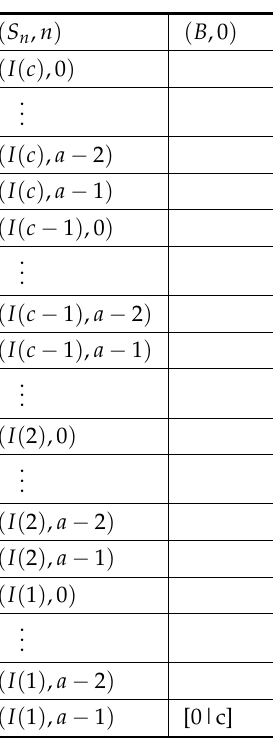
Table 4. Submatrix T Idle → Busy